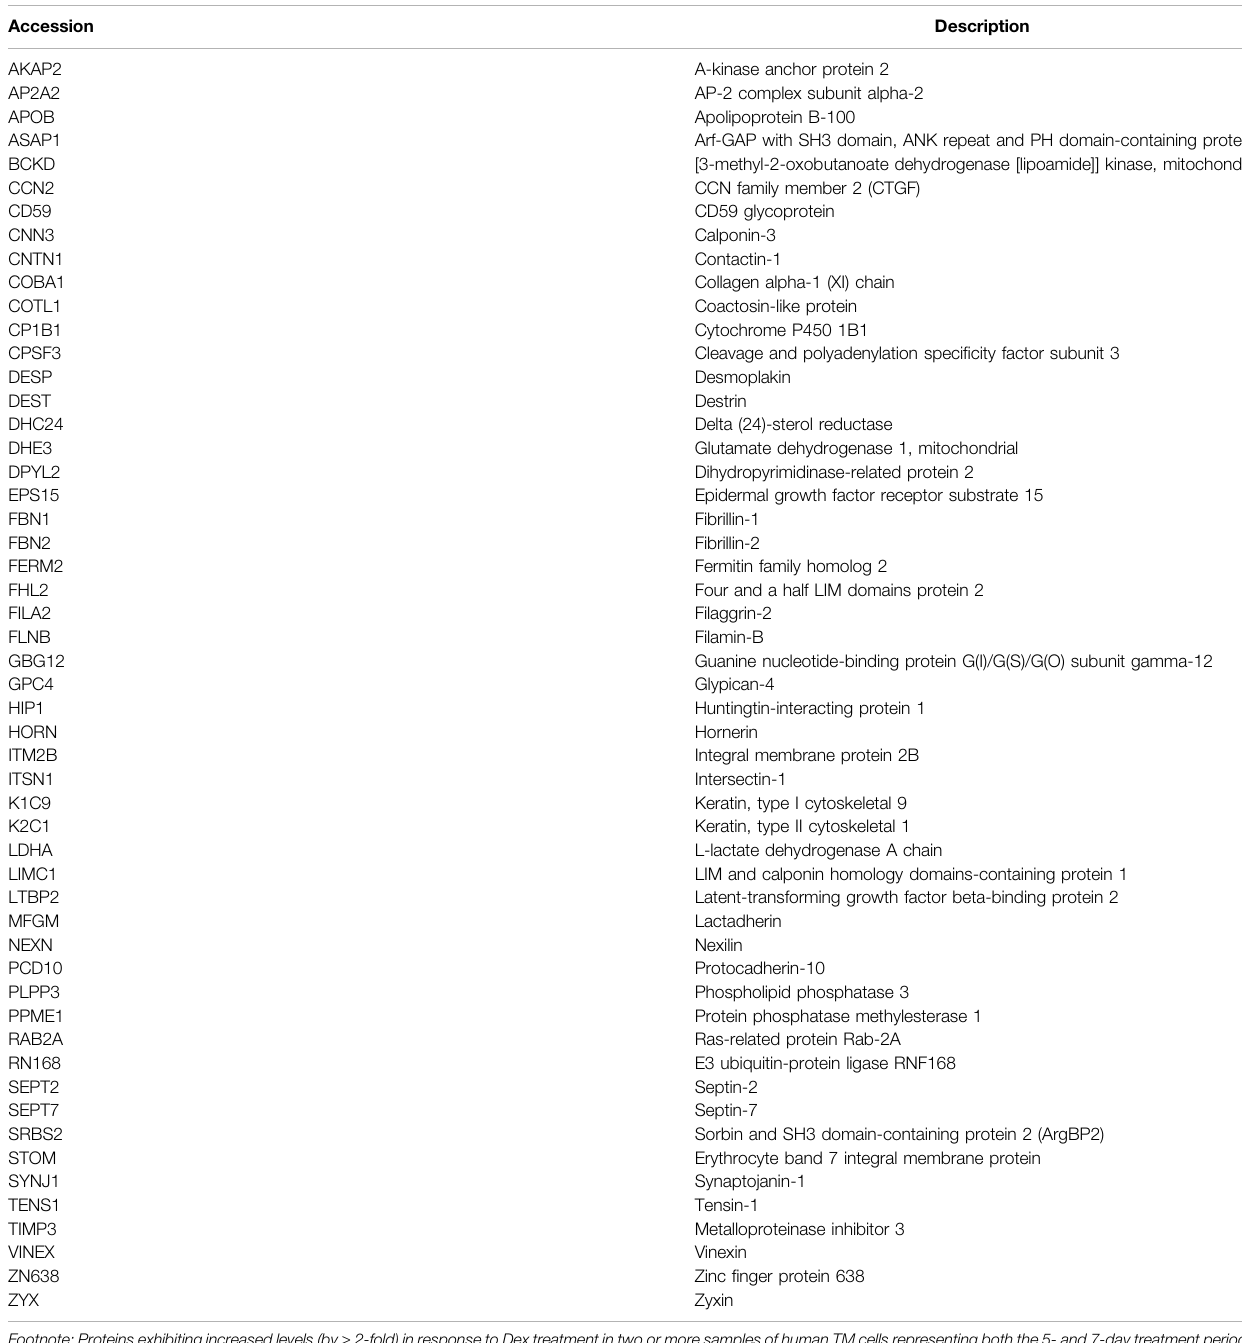
TABLE2| Proteinswhoselevelsareelevatedby ≥ 2-foldintwoormorenuclearfractionsamplesderivedfromDextreatedhumanTM cellsatboththe5-and7-dayexposure time points.